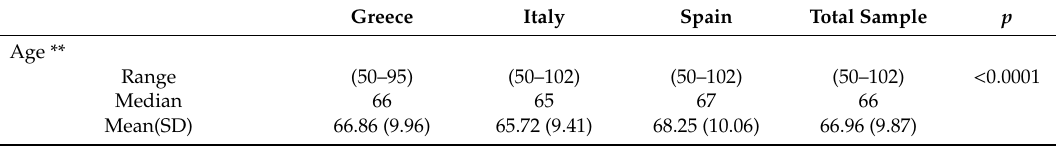
Table 1. Descriptive statistics § of 12,931 people aged 50 years and more living in Italy, Spain, and